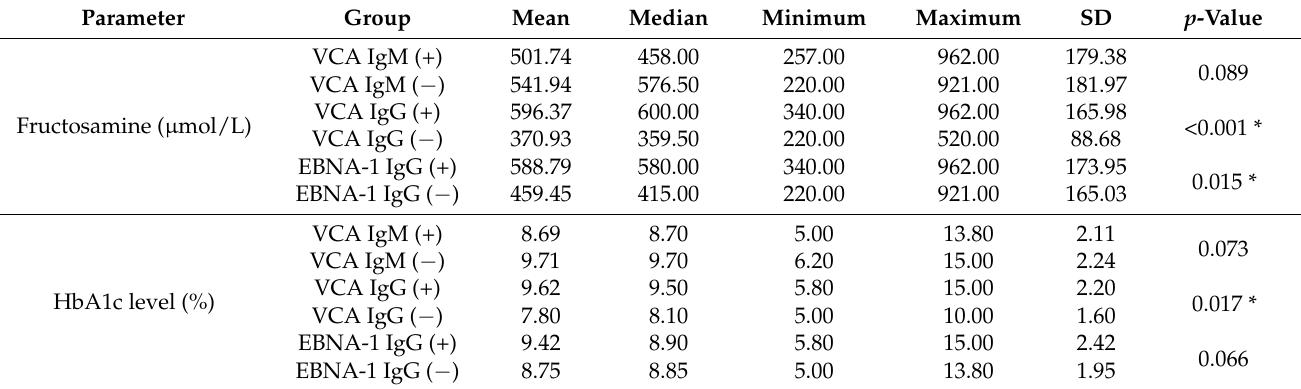
Table 8. Evaluation of selected parameters of carbohydrate balance in patients with type 1 diabetes